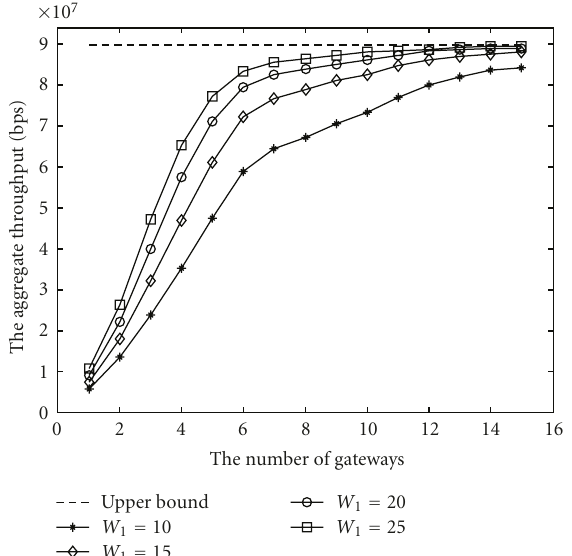
Figure 11: The comparison of the worst-case per-client throughput with uniformly distributed mesh